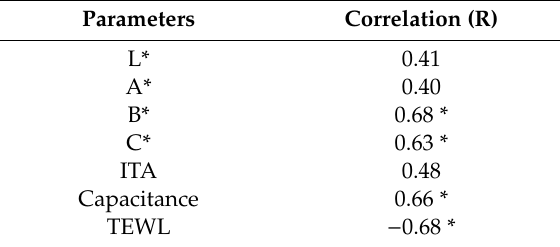
Table 1. Correlations between autophagic activity and skin physiological